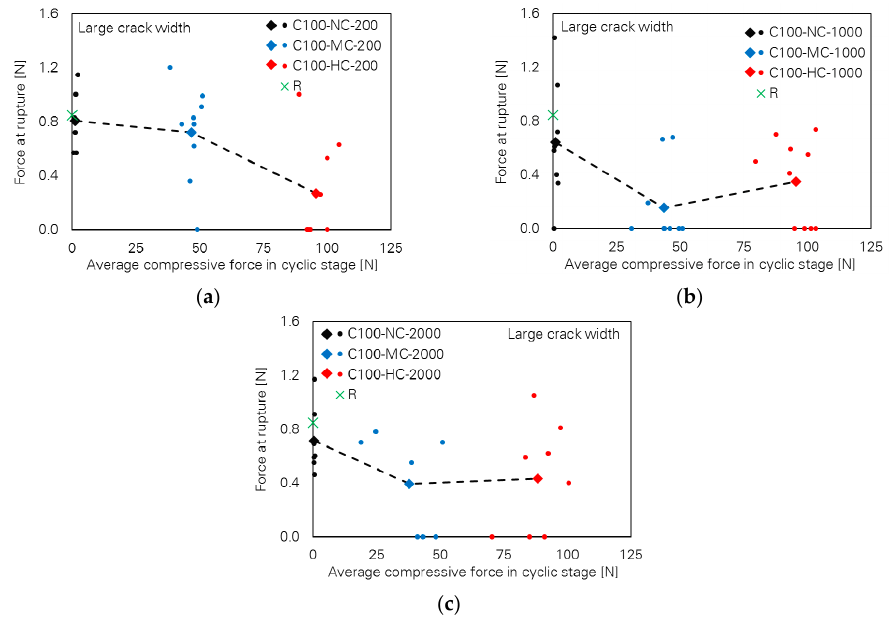
Figure 7. Influence of cyclic compressive force level on force at rupture of the specimens with large crack width; number of cycles: ( a ) 200, ( b ) 1000 and ( c ) 2000.